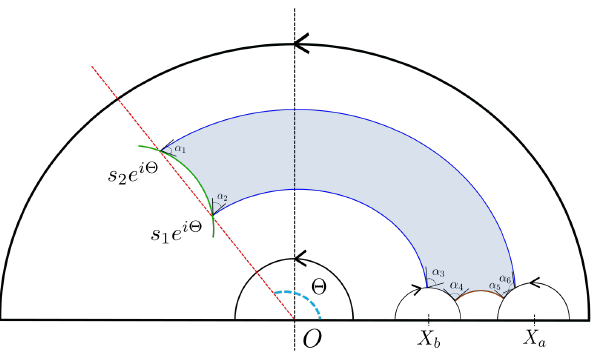
Figure 9. The blue shaded region corresponds to the volume between a set of geodesics in the inception sides that is helpful for calculations. To compute the full volume in the inception side, one needs to add the volume between s 1 and s 2 on the EoW brane and the green